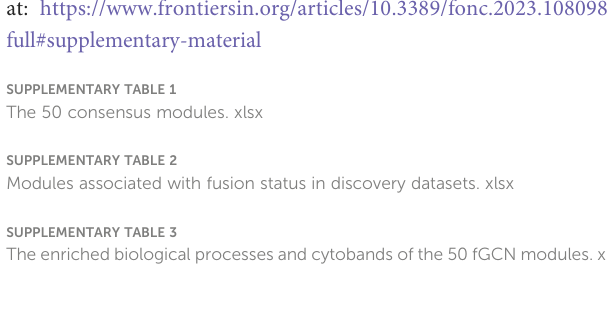
SUPPLEMENTARY TABLE 2 Modules associated with fusion status in discovery datasets. xlsx SUPPLEMENTARY TABLE 3 The enriched biological processes and cytobands of the 50 fGCN modules. xlsx